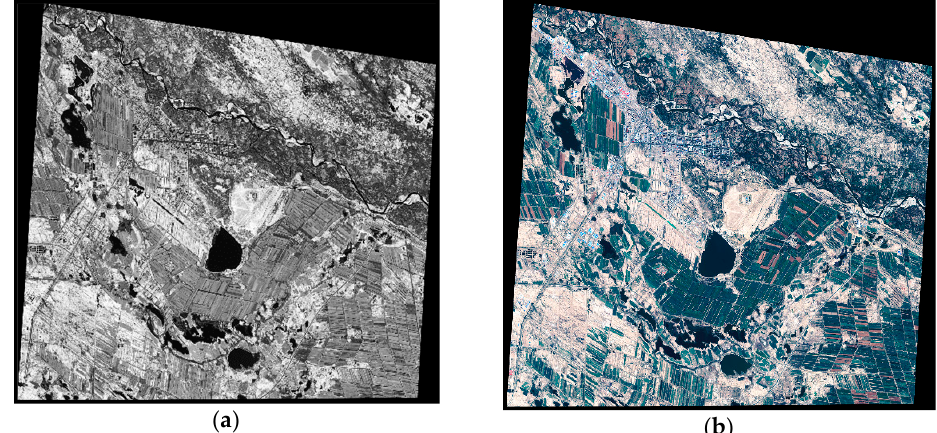
Figure 6. The satellite image of the test zone. ( a ) The full-color image that has 0.5 m ground resolution; ( b ) The color image that has 2 m ground resolution.